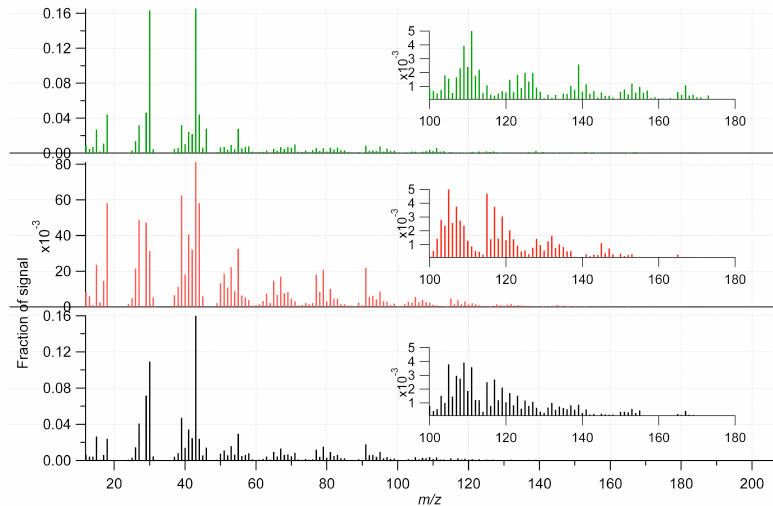
Fig. 10. Mass spectra of the three factors derived from PMF analysis with inserts showing expanded views. Factor one (black) is characterized by a large contribution from m/z 43 and significant 30 and 46. Factor two (red) has a significant signal on m/z 44 and 39, suggesting oxidized organics, and has no contribution from the nitrate masses. Factor three (green) has the largest relative contribution from nitrate masses and larger contributions on m/z > 100 than factor